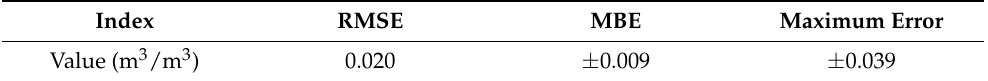
Table 3. Field measurement accuracy verification test results of self-developed moisture sensor.